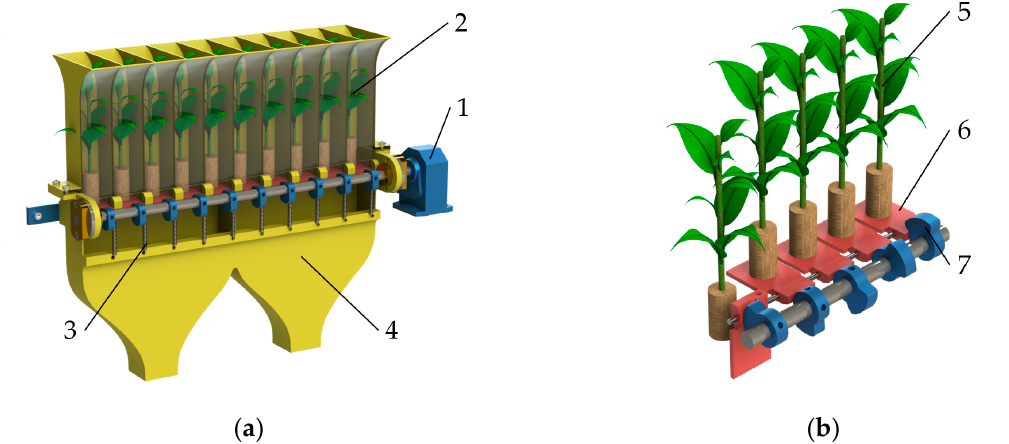
Figure 4. Interval seedling dropping device and its operation principle: (1) drive motor, (2) seedling separating cylinder, (3) spring, (4) seedling dropping cylinder, (5) seedling pot, (6) seedling carrying plate, (7) drive cam. ( a ) The schematic diagram of the interval seedling dropping mechanism. ( b ) The principle of the interval seedling dropping